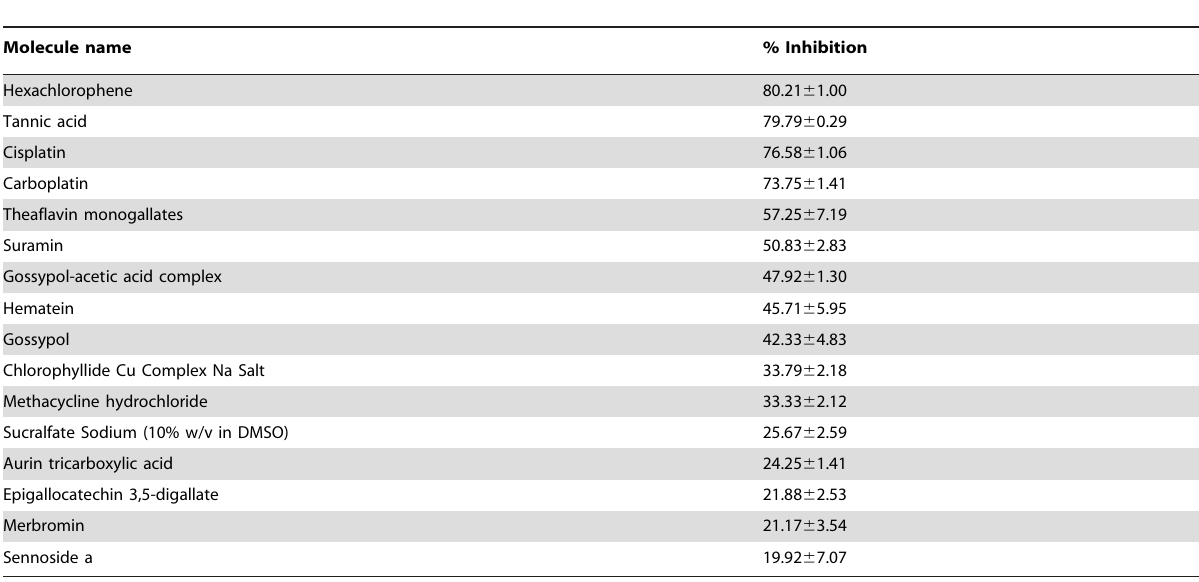
Table 1. Sixteen molecules inhibit hydrolysis of ATP by